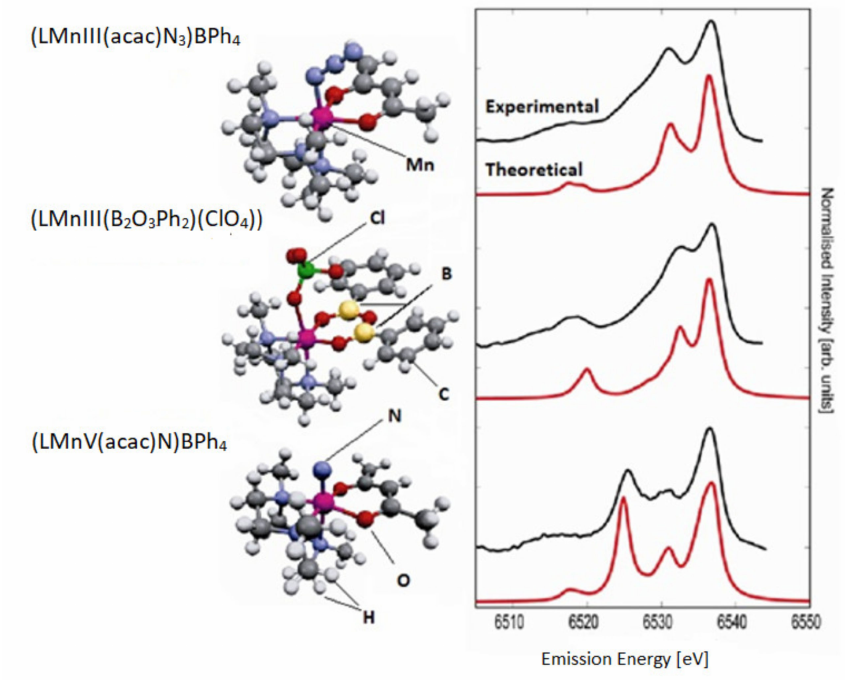
Figure 5. The experimental (top) and theoretical (bottom) valence-to-core XES spectra for three complexes. The shape of the experimental spectra is significantly dependent on the ligand type and oxidation state. Based on